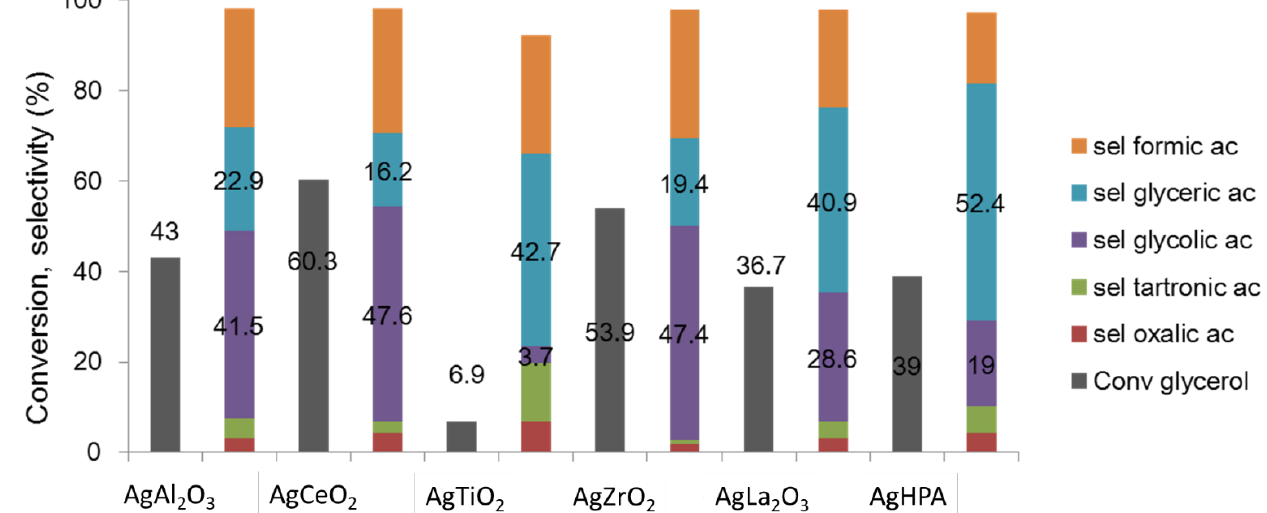
Figure 2. Glycerol oxidation using Ag-based catalysts. Reaction conditions: 5 h at 60 ◦ C, 5 bar O 2 , NaOH/GLY = 4 (molar ratio), 0.3 M glycerol, 0.5 g catalyst, 1.4 wt.% Ag/support, and batch reactor.